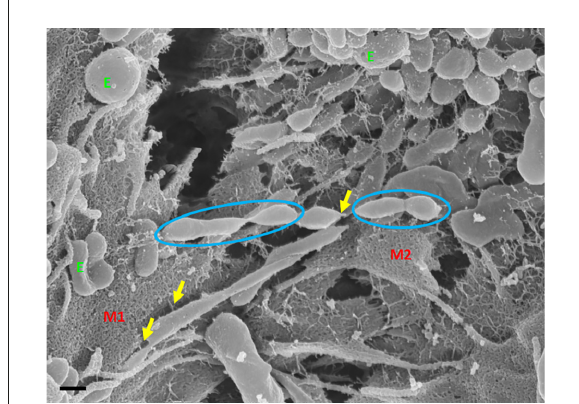
FIGURE4 An HR-SEM microgragh illustrating the interaction of the distal ends of TUNT structures with target cell membranes and the interaction between individual TF-exosomes to form nanotubules. E denotes clustering TF-exosomes on the BEC membrane surface. Yellow arrows indicate interaction points between the TUNT and the BEC membrane and between individual exosomes. M1 denotes the cell membrane on which TUNT originates and M2 denotes the target cell membrane. The blue circles indicate exosome fusion during TUNT formation. Scale bar = 300 nm.